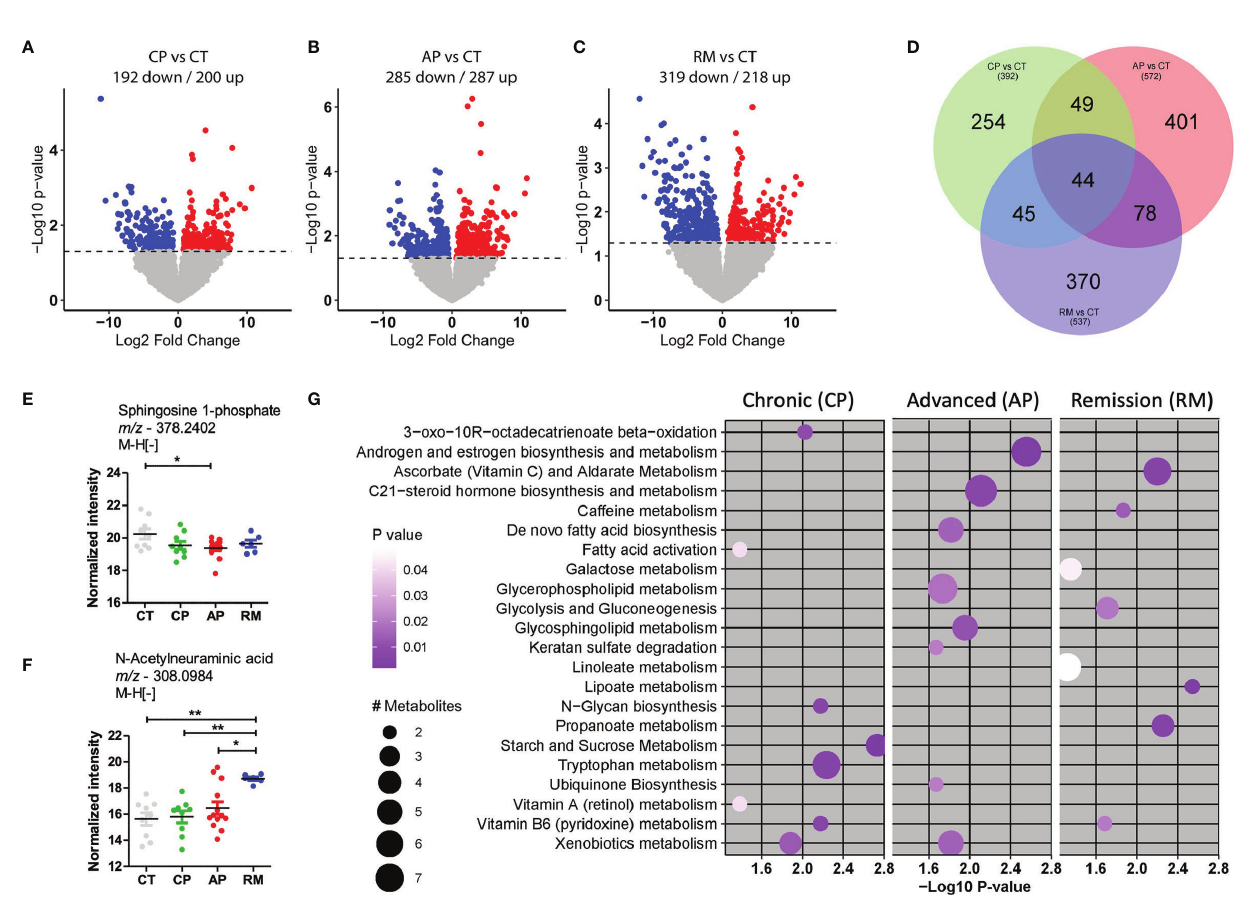
FIGURE 1 | Metabolites differentially abundant in CML patients in comparison with the control group. (A – C) Volcano plots to compare down- and upregulated metabolites in (A) . CML patients in the chronic phase (CP; n = 10) and control group (CT; n = 9); (B) CML patients in the advanced phase (AP, n = 13) and control group (CT); (C) CML patients in remission post-TKI therapy (RM; n = 6) and control group (CT). (D) Venn diagram of differentially abundant metabolites in each group, after comparison. (E, F) Scatter-plots of the amount of top predicted metabolites in CML patients and the control group. Sphingosine-1-phosphate was less abundant in CML-AP patients than in the control group. N-Acetylneuraminic acid was more abundant in patients in remission than in control subjects and CML-CP and CML-AP patients. (G) The most representative metabolic pathways in CML patients, compared with the control group. The circle size represents the number of differentially abundant metabolites, and the circle color means the degree of signi fi cance ( p -value magnitude) after comparison among groups. Signi fi cant metabolite features were identi fi ed by ANOVA with repeated measures, associated with Tukey ’ s multiple comparisons test (* p < 0.05; ** p <